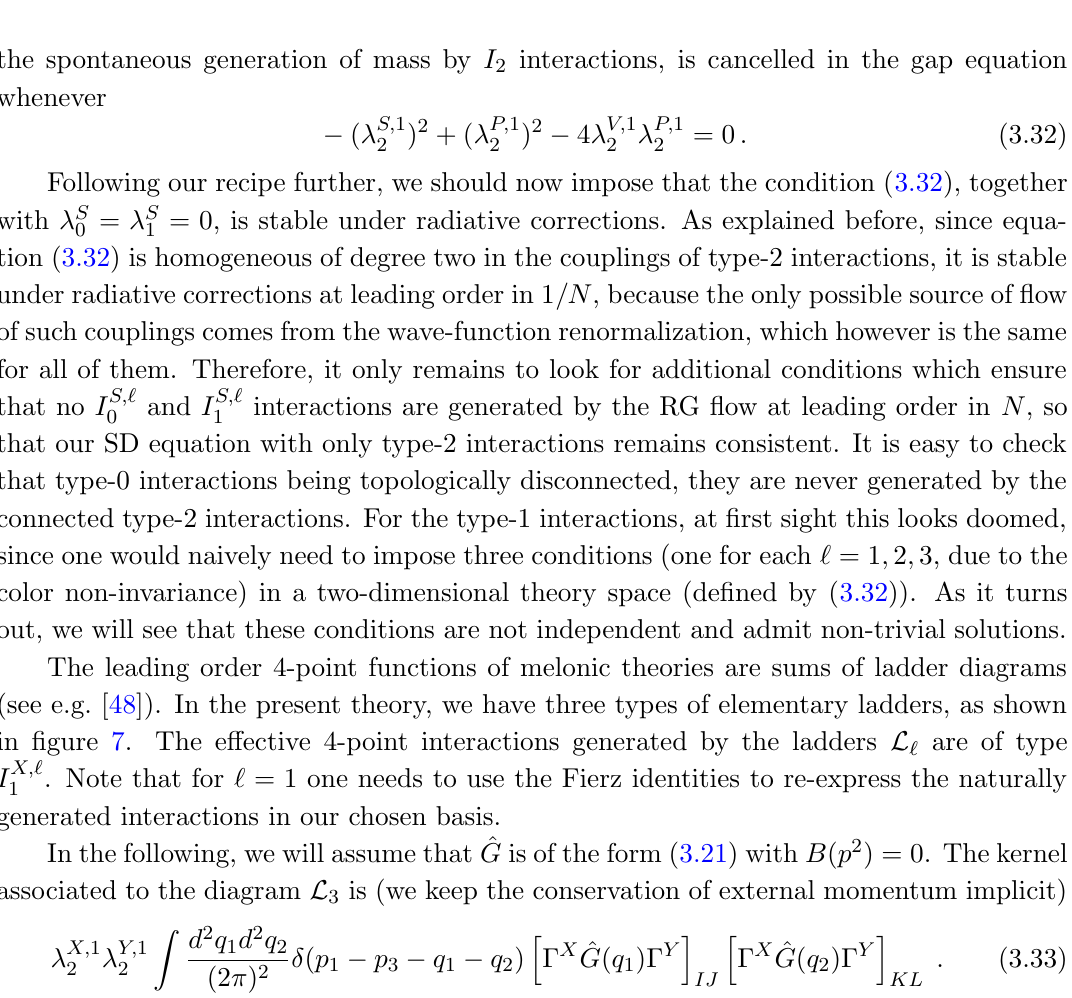
Figure 7 . The three types of ladders contributing to the leading-order 4-point